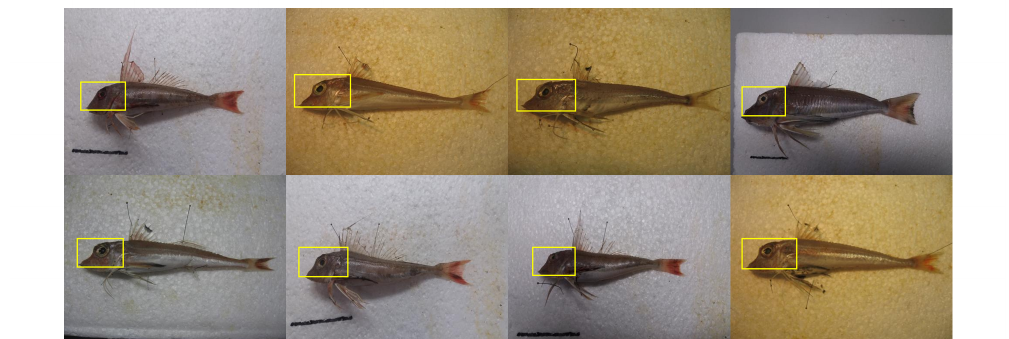
Figure 12. Example of the detection results performed on the test images using the trained faster region-based convolutional network (Faster R-CNN) object detector. The obtained ROI is shown in